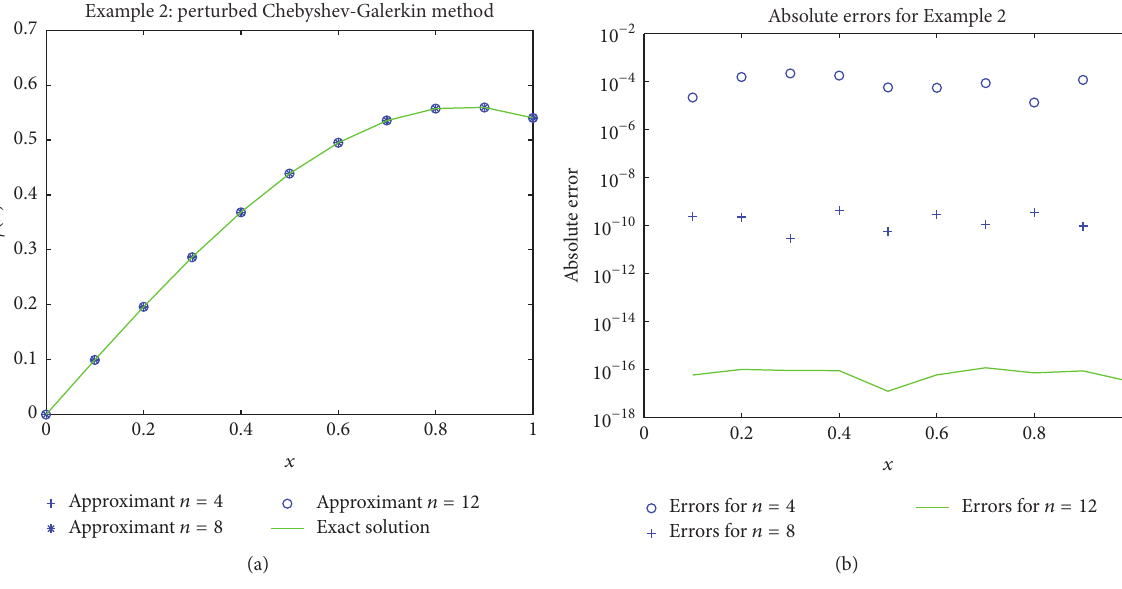
Figure 2: The approximate solution for Example 2 and its absolute errors for different 𝑛 .